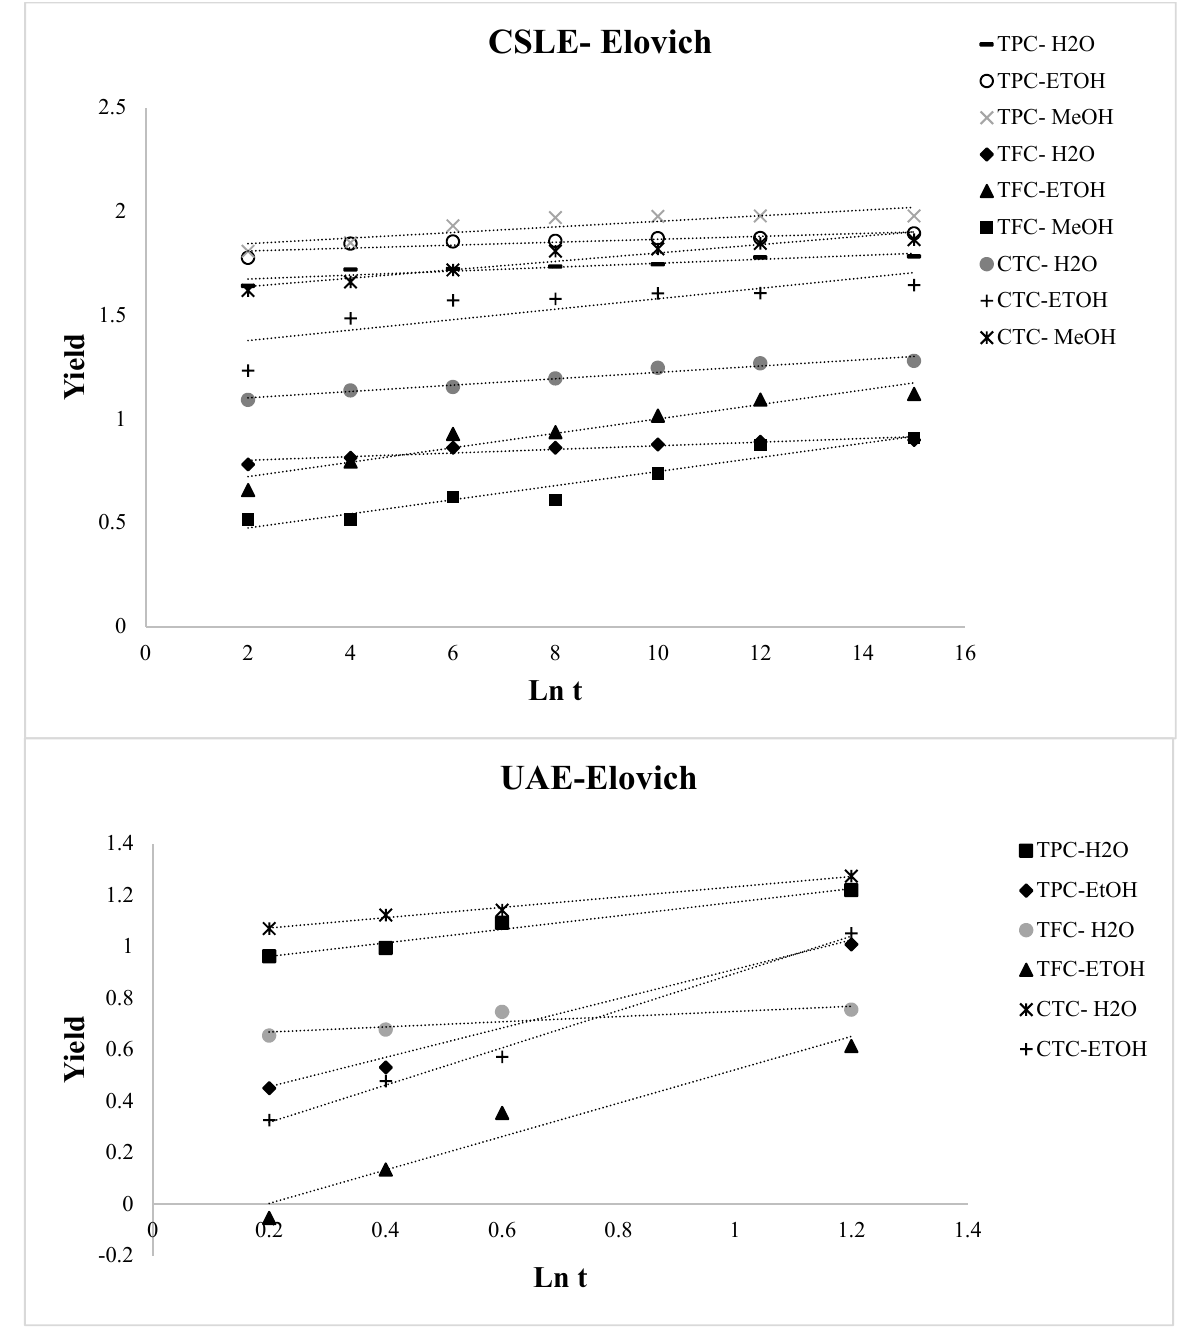
Figure 7. Plot of Elovich’s model for conventional solid-liquid extraction (CSLE) and ultrasound-assisted extraction (UAE) for the total phenolic compound (TPC), total flavonoid compound (TFC), and total condensed tannin compound (CTC) using the different selected solvents.